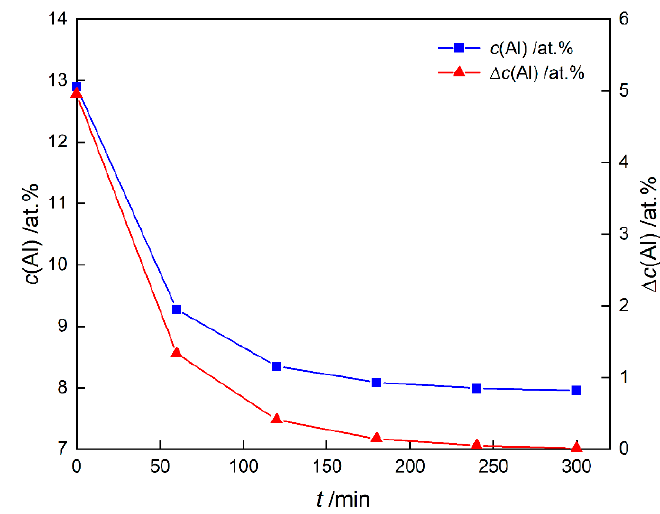
Figure 6. The average concentration of Al element in the γ matrix c (Al) and the deviation curve of the Al concentration from the equilibrium state ∆ c (Al).